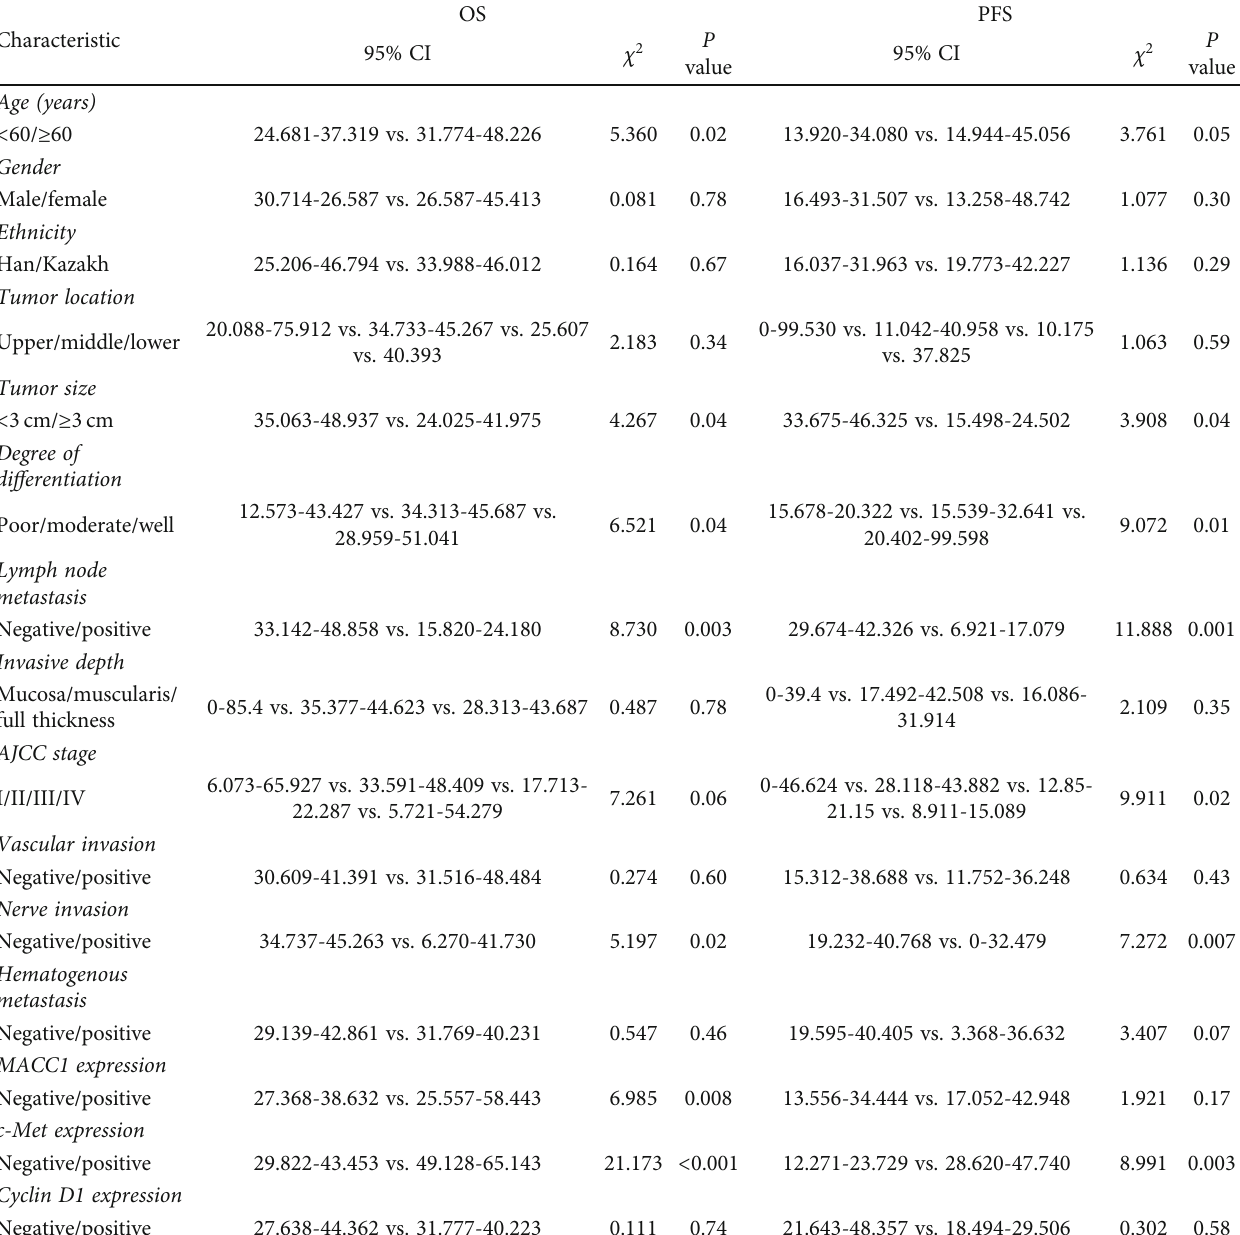
Table 6: Univariate analysis of factors associated with OS and PFS in ESCC